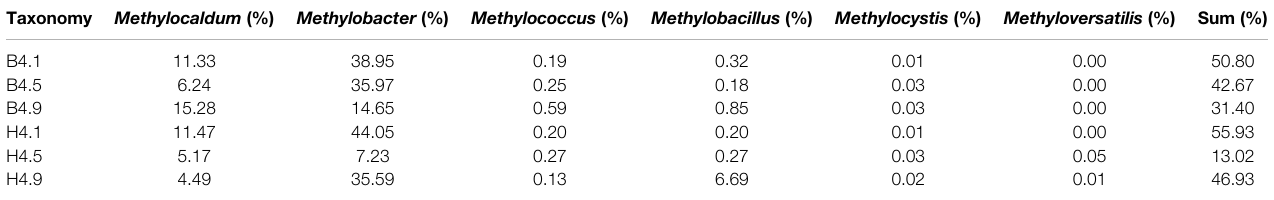
TABLE 3 | Relative abundance of methane-oxidizing bacteria of different cover layers at the end of the